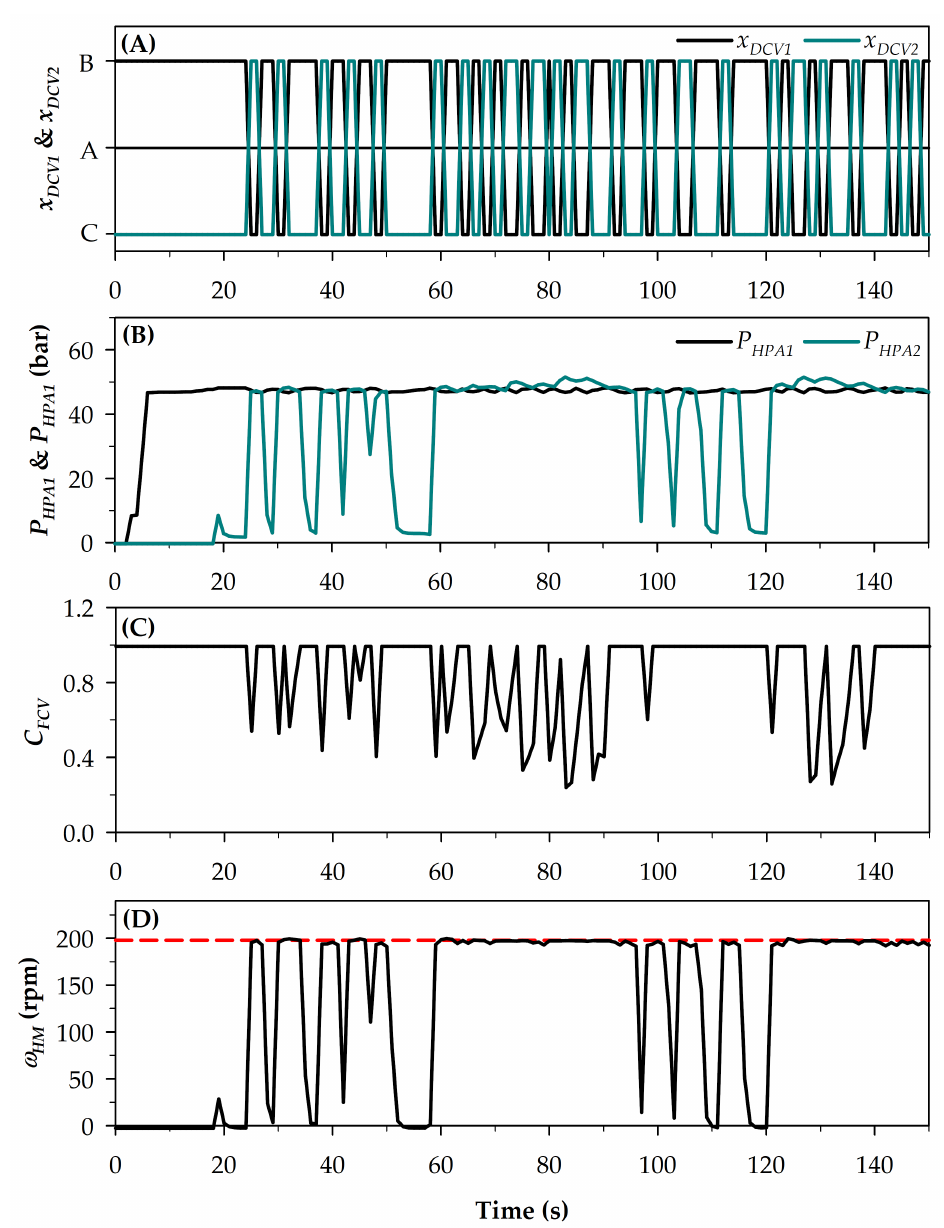
Figure 16. The behavior profiles of selected components in the improved HPTO unit. ( A ) The active position of DCV 1 and DCV 2 . ( B ) The oil pressure in HPA 1 and HPA 2 . ( C ) The flow coefficient of FCV. ( D ) Hydraulic motor